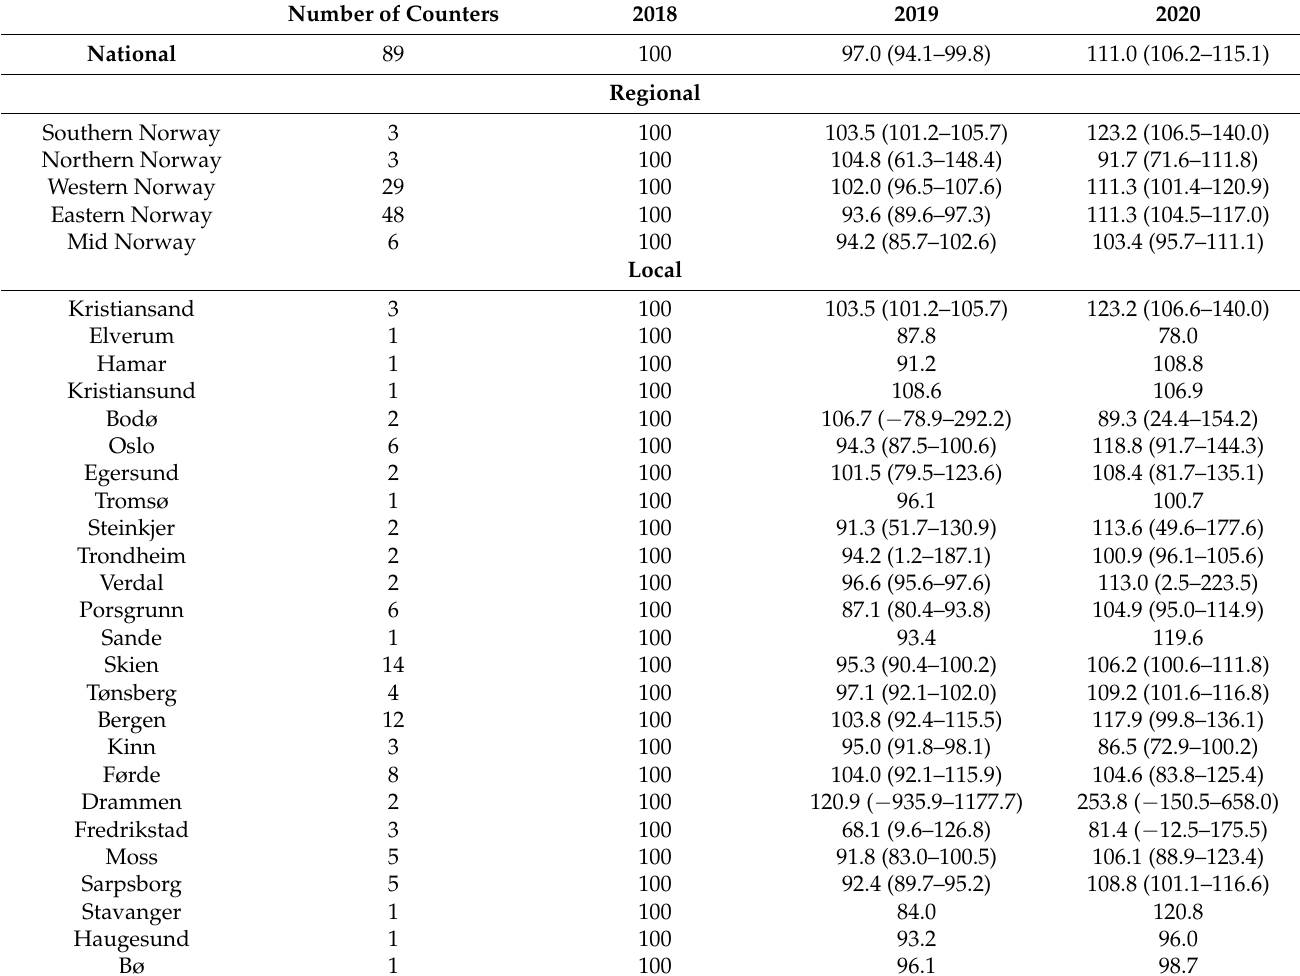
Table 2. National, regional, and local weighted * indices with a 95% confidence interval from 2018 to 2020.